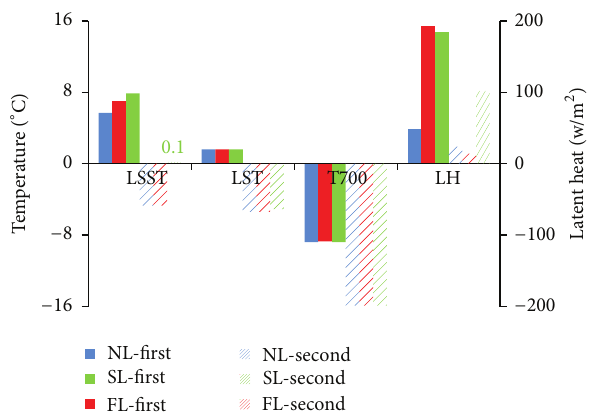
Figure 7: Simulated LSST, T700, LH averaged over lake and LST averaged over land in the red square in Figure 5(a) in the first and second GSL precipitation event in SL, FL, and NL